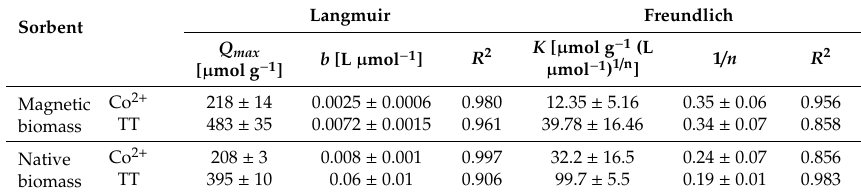
Table 2. Parameters of Langmuir and Freundlich isotherms for Co 2 + and thioflavin T adsorption by native and magnetically responsive biosorbents calculated using nonlinear regression analysis.